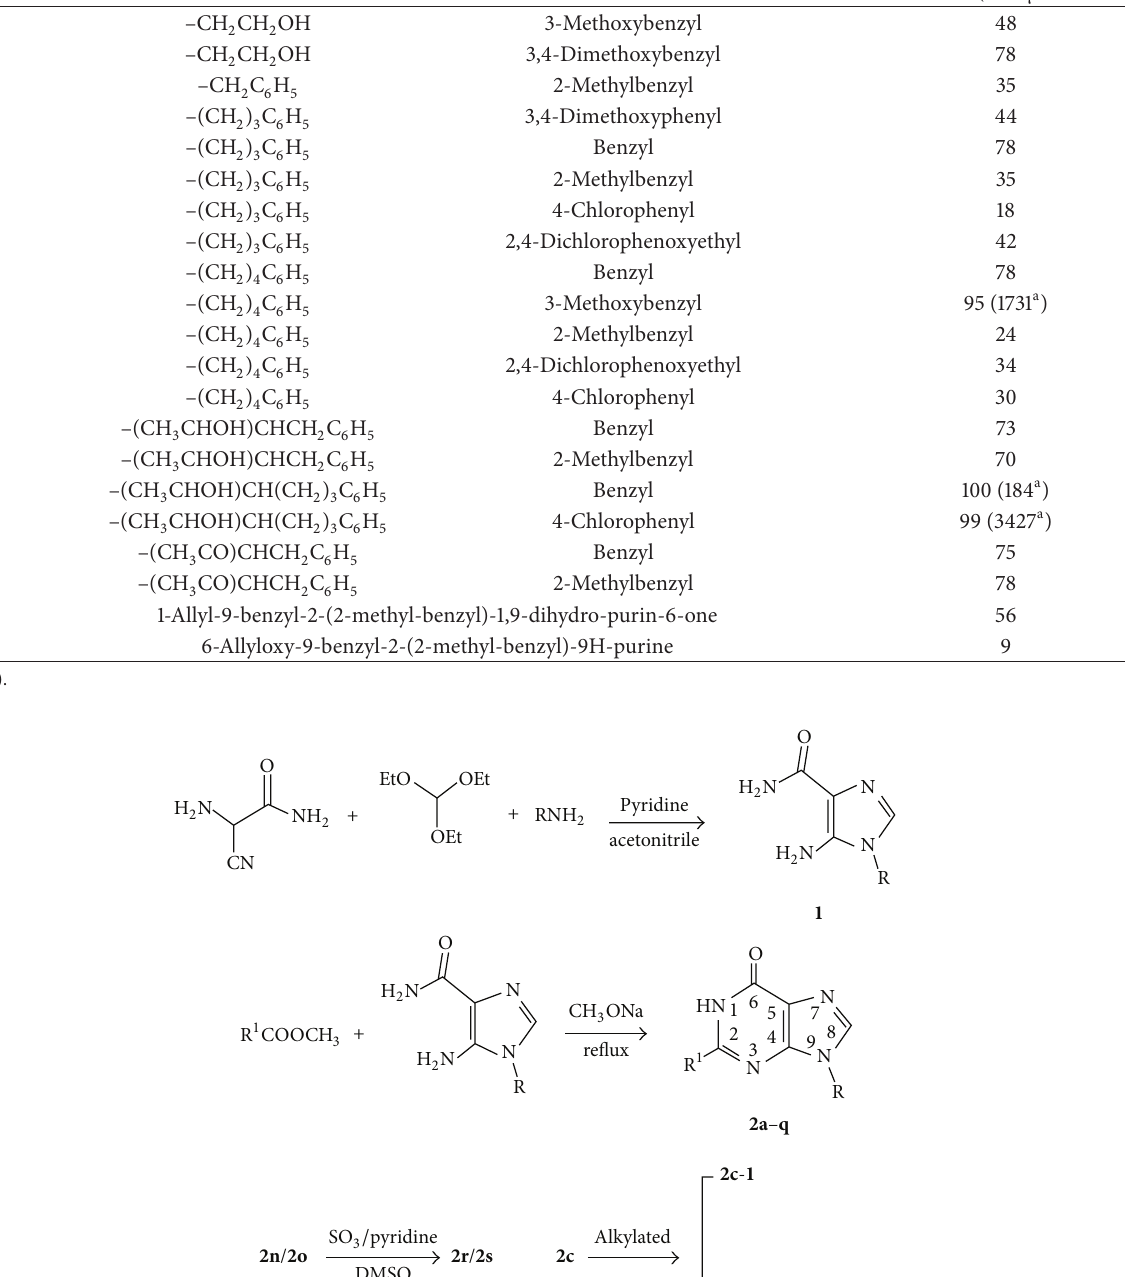
Table 1: Molecular structures and PDE2 inhibitory activity of purin-6-one derivatives (see Scheme 1, compounds 2a –2 q ). Compound